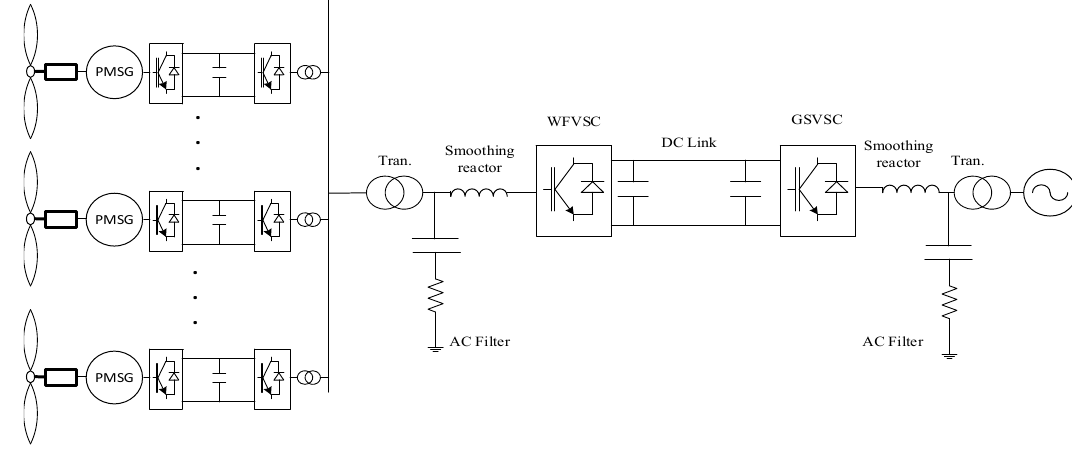
Figure 11. Schematic diagram of typical VSC-HVDC system.